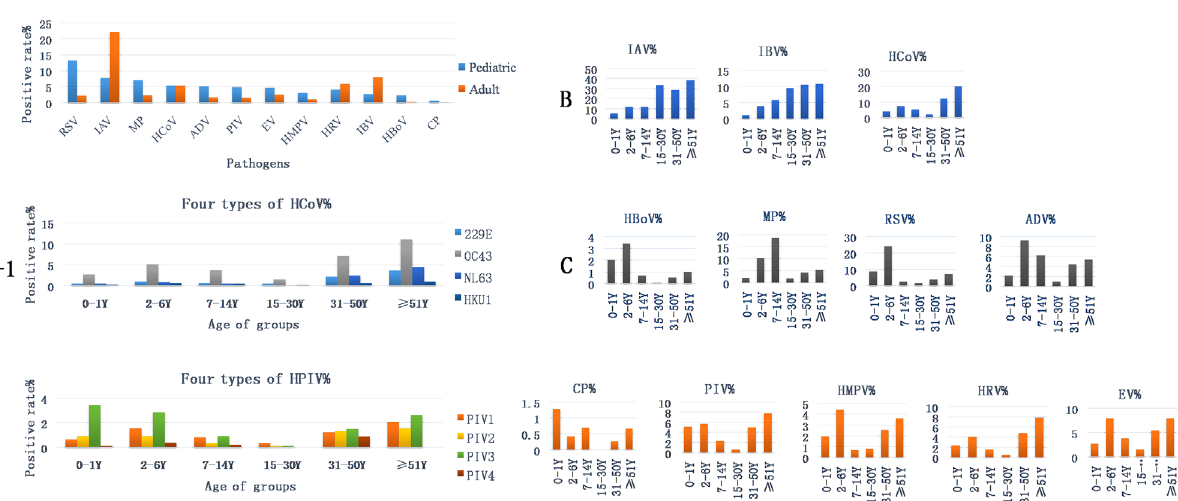
Fig 4. Pathogens ’ distributions within age subgroups over five years. A, PDR differences in pediatric and adults subgroups; the (%) in B, B-1, C, D, and E indicates the PDRs of pathogens in different age